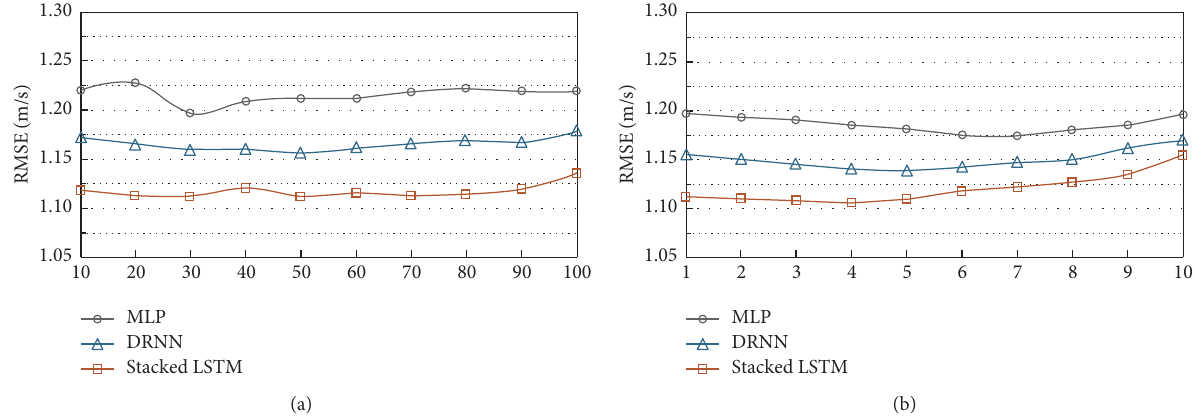
Figure 7: Sensitivity of model parameters on the Taipei gauge: (a) number of neurons in a middle layer and (b) length of middle layers.